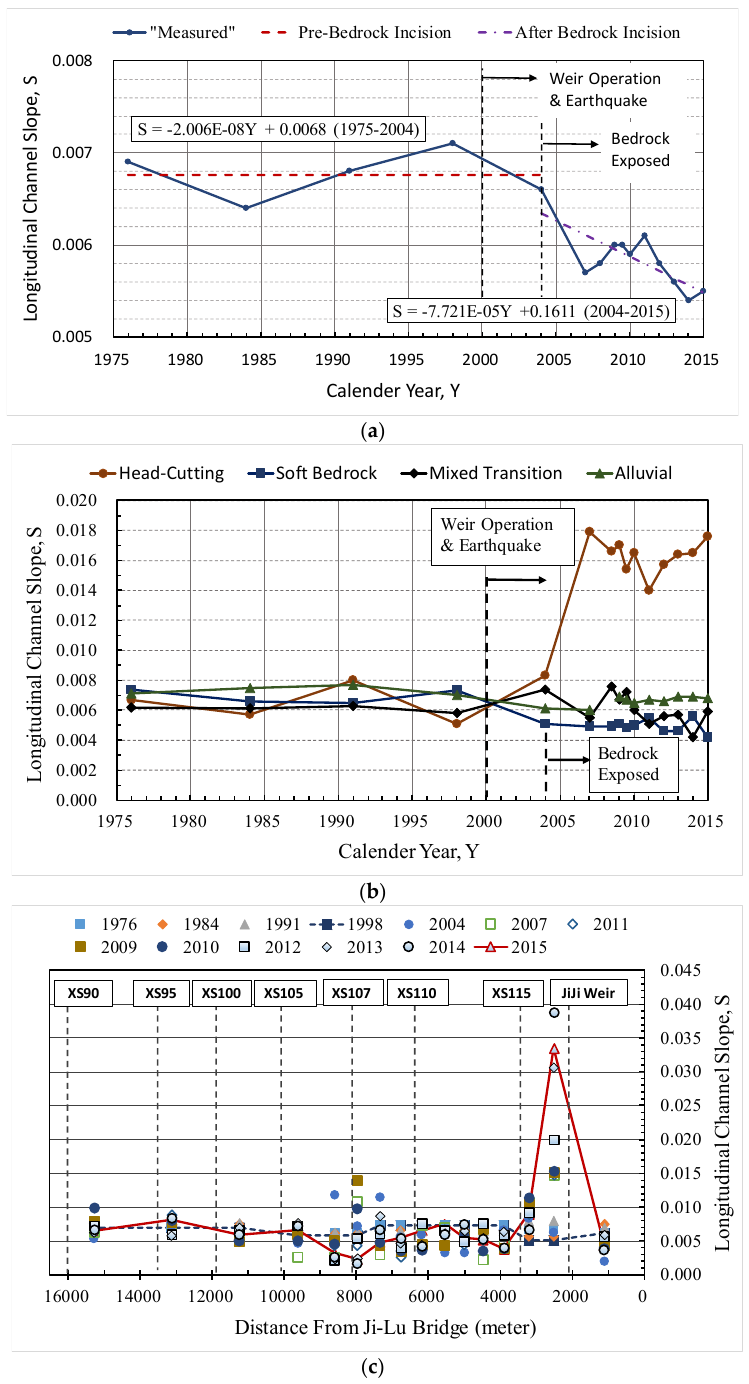
Figure 9. Longitudinal slope evolution with three different spatial scale: ( a ) Large-scale: The entire study reach; ( b ) medium-scale: Divided the study reach into four sub-reaches; and ( c ) local scale: Calculated between each cross-section.